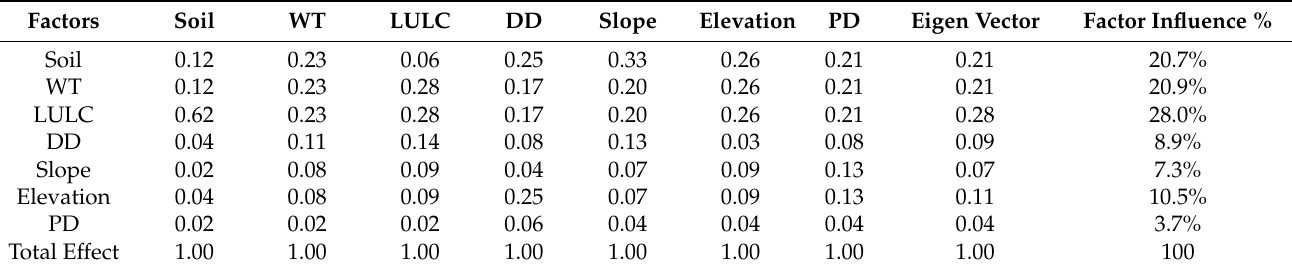
Table 4. Normalized pairwise comparison matrix.